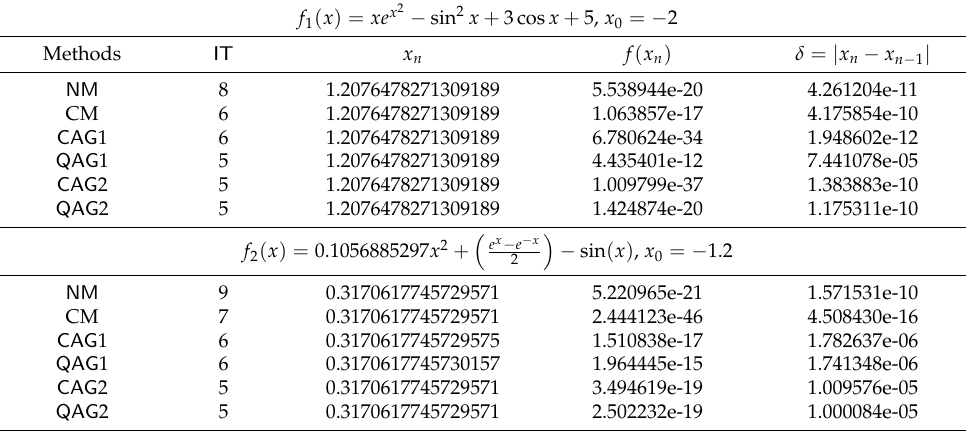
Table 7. The methods and their IT , x n , f ( x n ) and δ